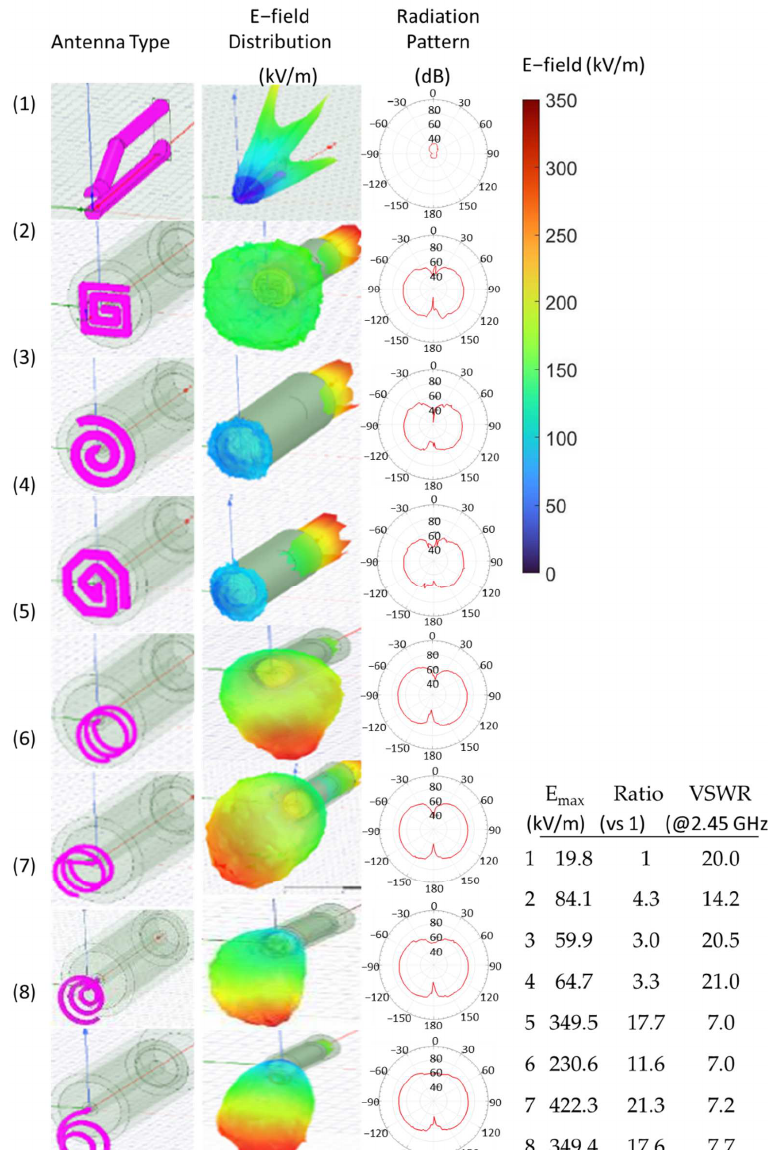
Figure 4. The electric field inside a spherically charged distribution and the radiation pattern of capacitor-like antenna (Antenna No. 1), square-shaped flat spiral antenna (Antenna No. 2), circular- shaped flat spiral antenna (Antenna No. 3), octagonal-shaped flat spiral antenna (Antenna No. 4), directly mounted helical coil (Antenna No. 5), bent-mounted helical coil (Antenna No.6), conical spiral antenna with an increasing diameter (Antenna No. 7), and conical coil with decreasing diameter (Antenna No.8). The maximum electric field strength, the ratio of the electric field versus the antenna 1, and the voltage standing wave ratio (VSWR) at 2.45 GHz for each antenna type are also shown.